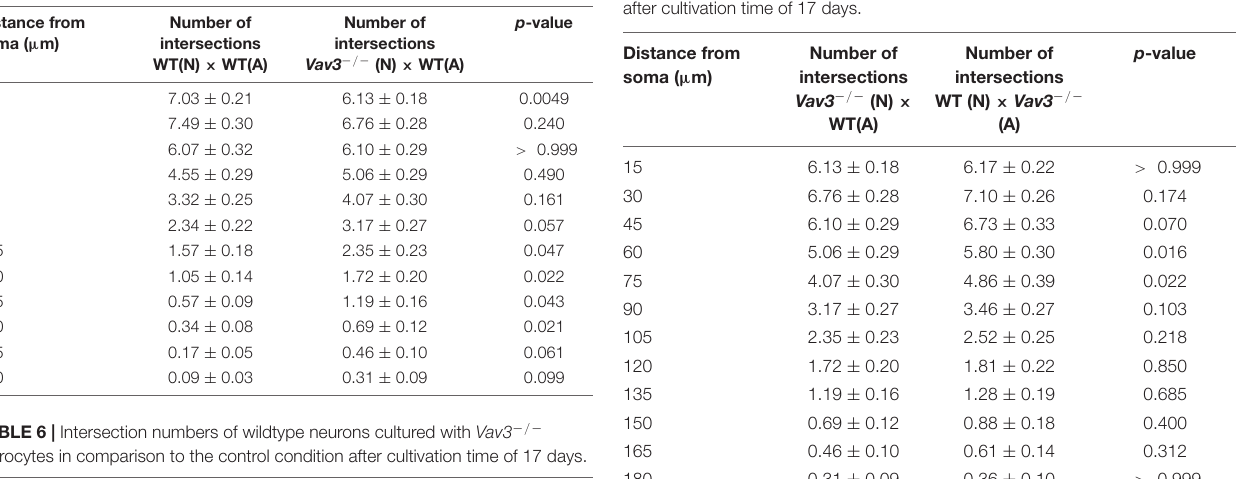
FIGURE 3 | cultured with wildtype astrocytes showed a significantly reduced dendritic length in comparison to both other conditions. Dots are representing single analyzed dendrites. (H) The quantification of the number of dendrites revealed no significant differences between all analyzed conditions. Dots are representing individual neurons analyzed for their number of dendrites. As already described in Figure 2 five experimental repetitions ( N = 5) were performed for the culture combinations WT(N)/WT(A) and Vav3 − / − (N)/WT(A) while three experimental repetitions ( N = 3) were performed for the combination WT(N)/ Vav3 − / − (A) for the Sholl analysis. Furthermore, 40 neurons ( n = 40) were recorded and analyzed per experimental repetition. For the dendritic lengths and numbers 3 experimental repetitions ( N = 3) were performed with 20 quantified neurons ( n = 20) per repetition. Kruskal-Wallis test with a following Dunn’s multiple comparison test; * p ≤ 0.05, ** p ≤ 0.01 and *** p ≤ 0.001, data are represented as mean ± SEM. Scale bar: 50 µ m.